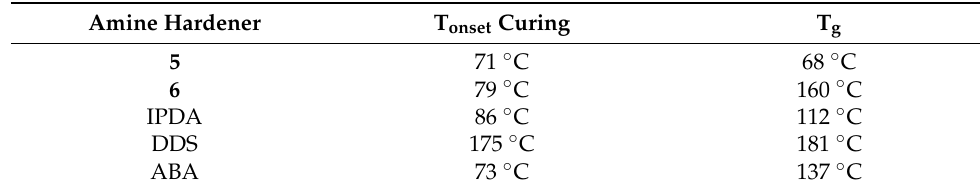
Table 1. Onset temperatures of the curing reaction and the glass transition temperatures (T g ) of the polymers formed by the investigated amines with DGEBA.